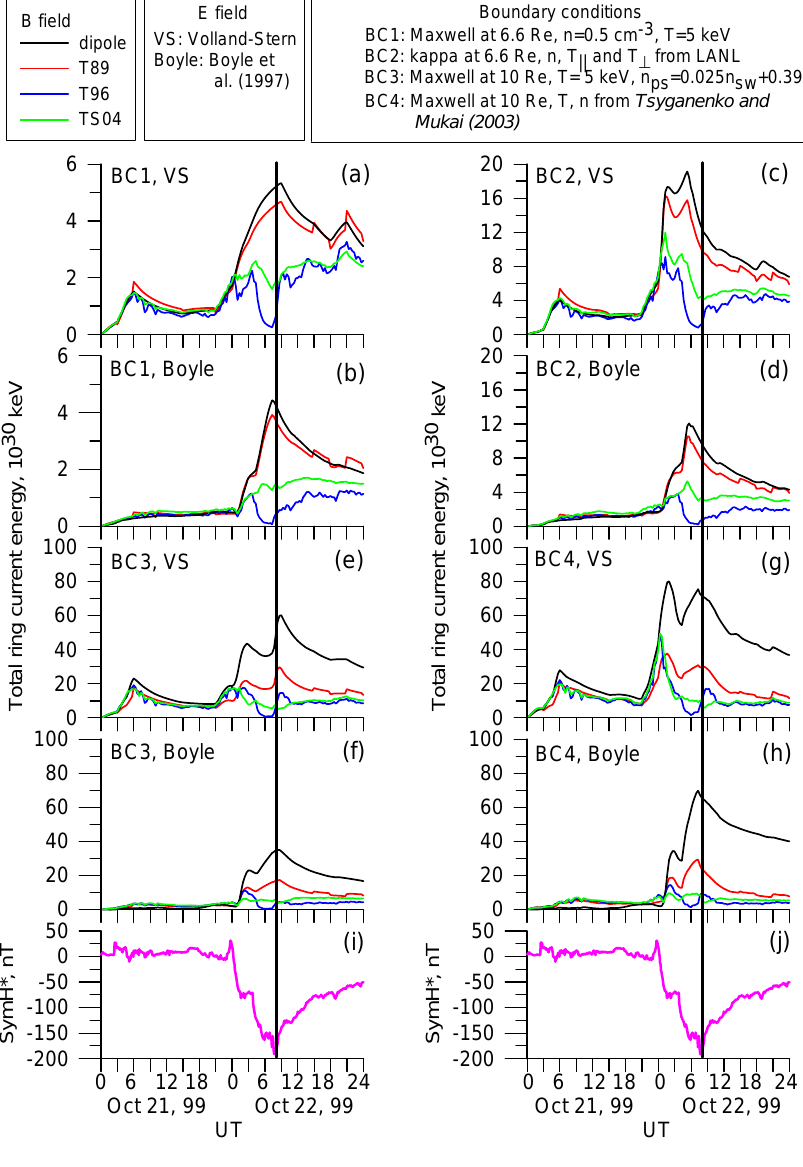
Fig. 3. Similar to Fig. 2 but for intense storm on 21–22 October